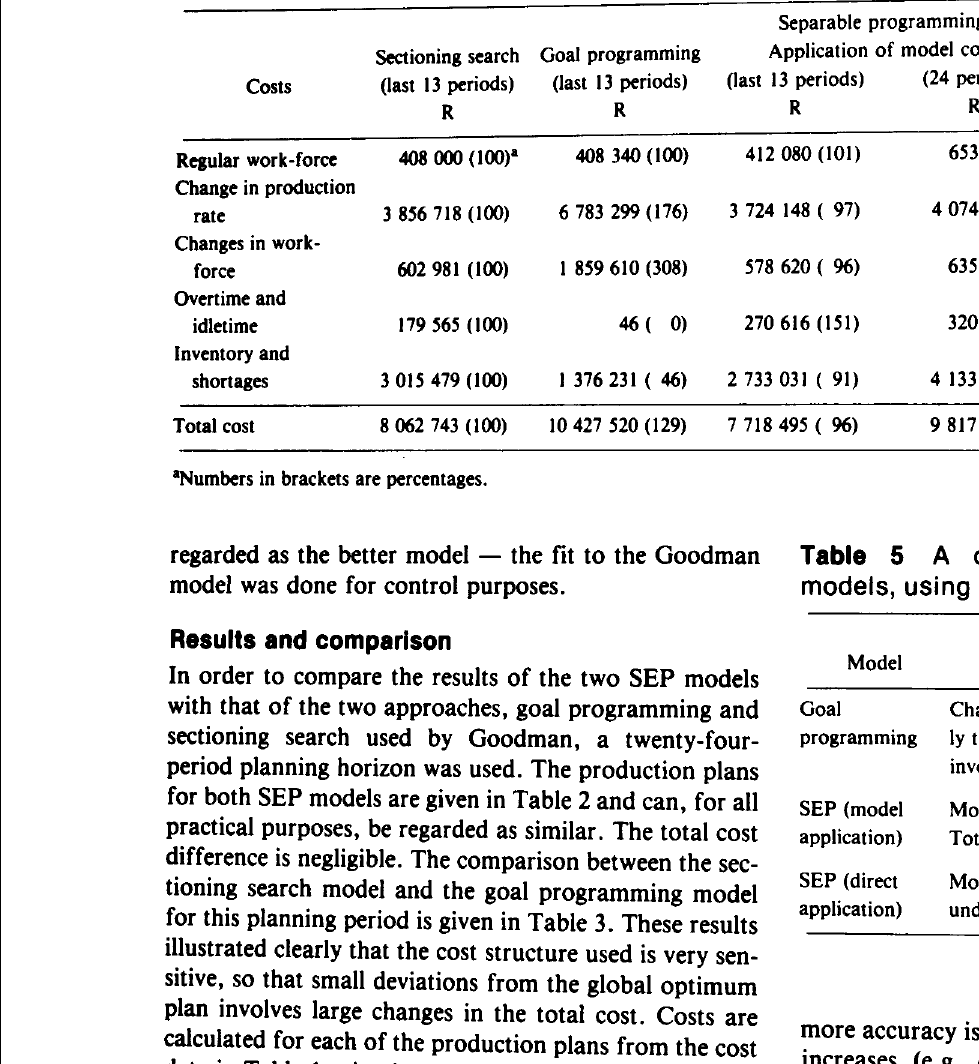
Table 4 A comparison of the cost areas and total cost associated with each solution methodology (All costs calculated using Table 1)